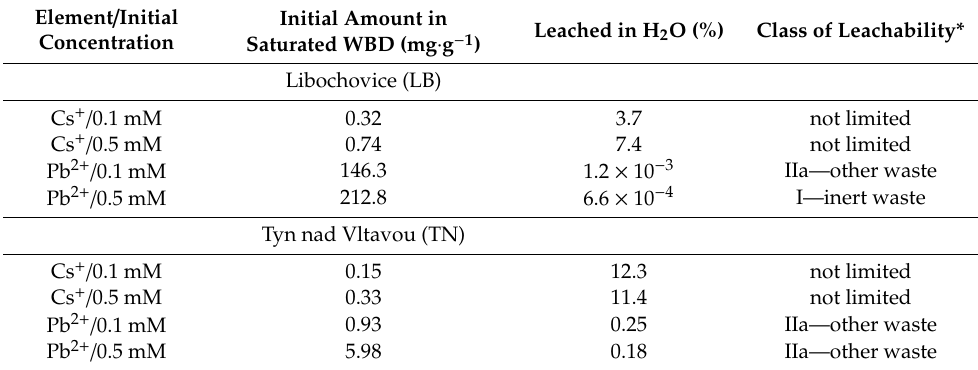
Table 4. Leachability of Cs / Pb from